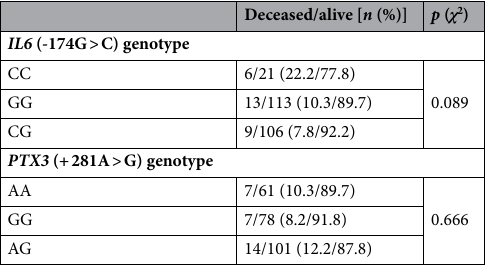
Table 6. Genotype frequencies in deceased and alive end-stage renal disease patients (1-year follow-up), according to IL6 (rs1800795) and PTX3 (rs2305619) polymorphisms. χ 2 Pearson’s Chi-squared test, IL6 interleukin 6, PTX3 pentraxin